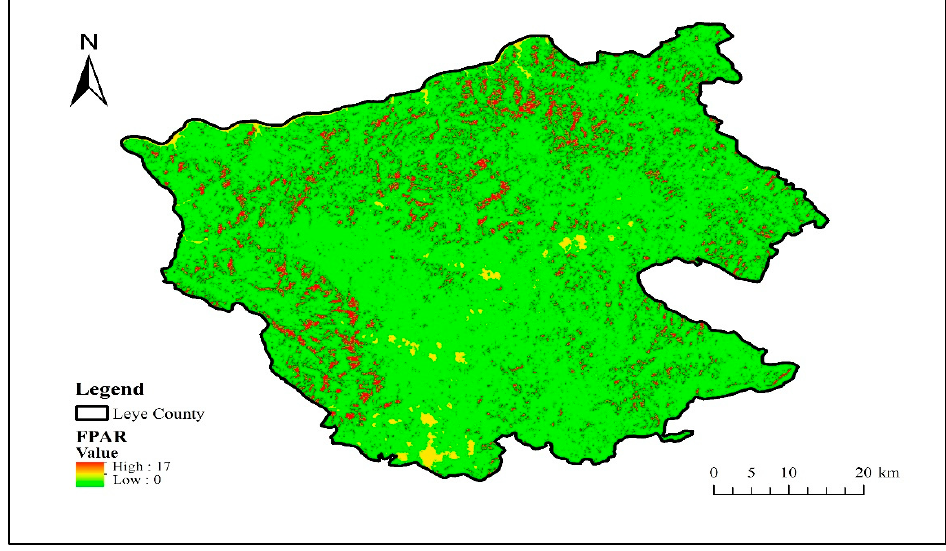
Figure 6. Distribution map of FPAR.